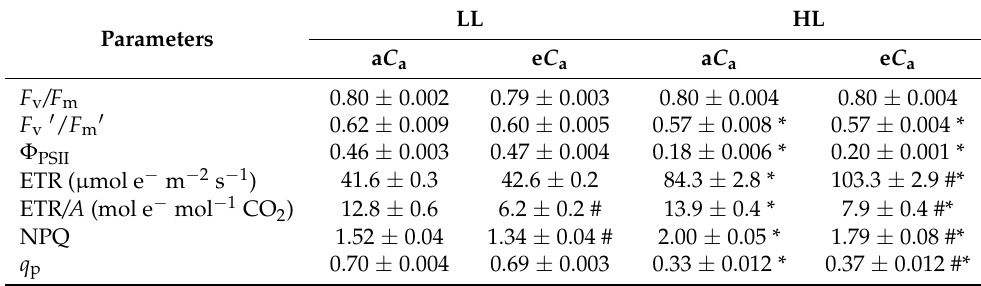
Table A2. The effect of light intensity [low (LL) or high (HL)] and CO 2 supply [ambient (a C a ) or elevated (e C a )] on photosynthetic traits of coffee plants: the maximum photochemical